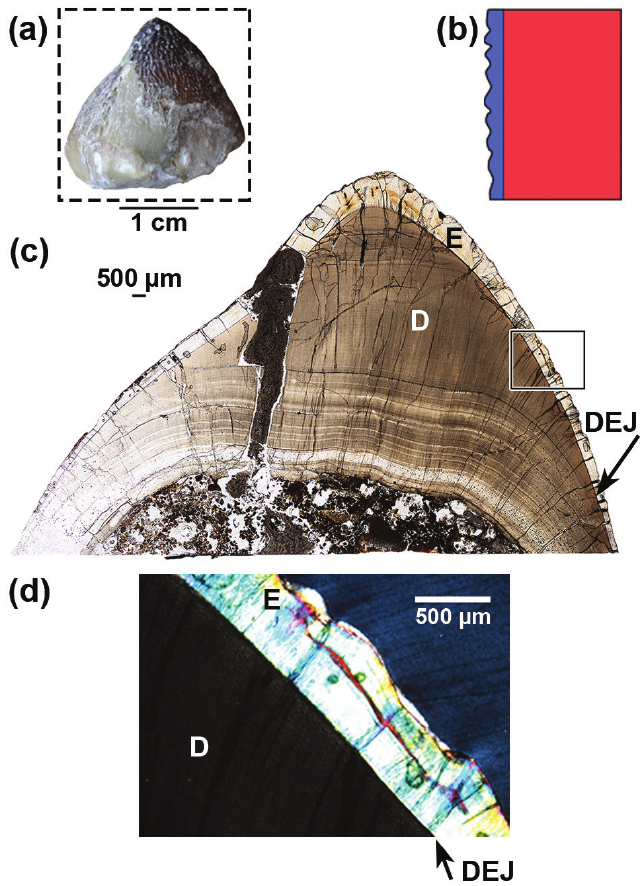
Figure 6. Anatomy of coarse anastomosing texture on a Globidens simplex tooth (MHNM.KHG.221). A, tooth in oblique view with approximate plane of section indicated by the dashed box; B, schematic diagram illustrating the relationship between the enamel (blue) and the dentine (red); C, longitudinal section seen under plane polarized light. Box indicates the region magnified in (D). D, close- up of the dentine-enamel junction viewed under crossed polarized light. Abbreviations: D, dentine; DEJ, dentine-en- amel junction; E,